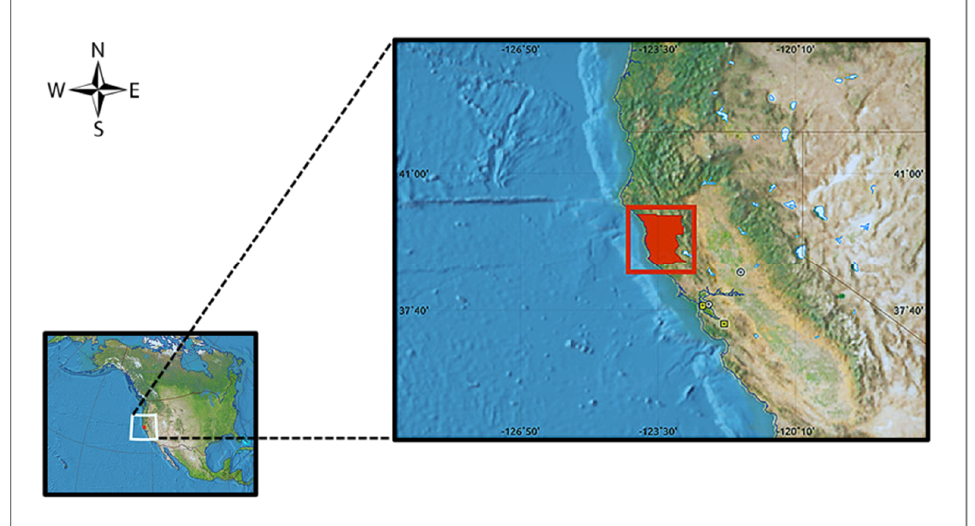
Figure 1. Location of Mendocino County (red square), which is situated in northern California and approximately 160 miles (257 km) north of the city of San Francisco and 280 miles (450 km) south of the state of Oregon.